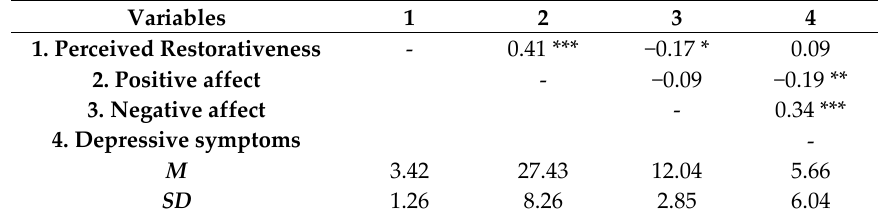
Table 1. Bivariate correlations, means, and standard deviations (SD) of key study